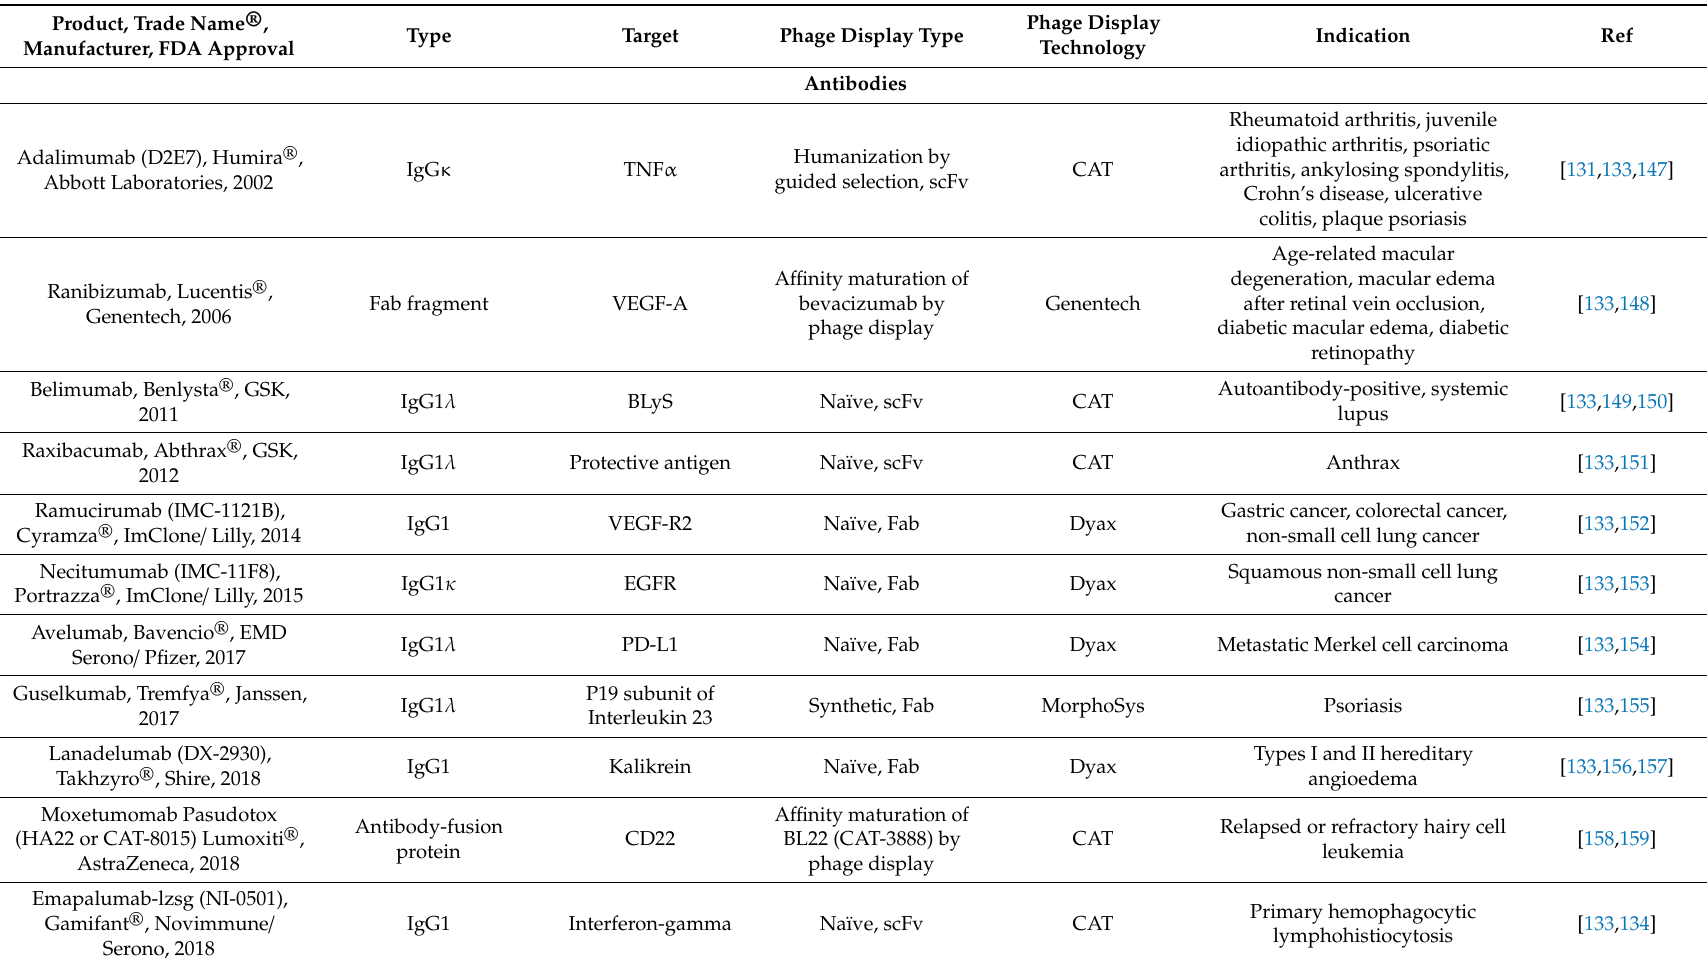
Table 2. Selected phage display-derived antibodies / peptide therapeutics approved by FDA, as of Dec 06